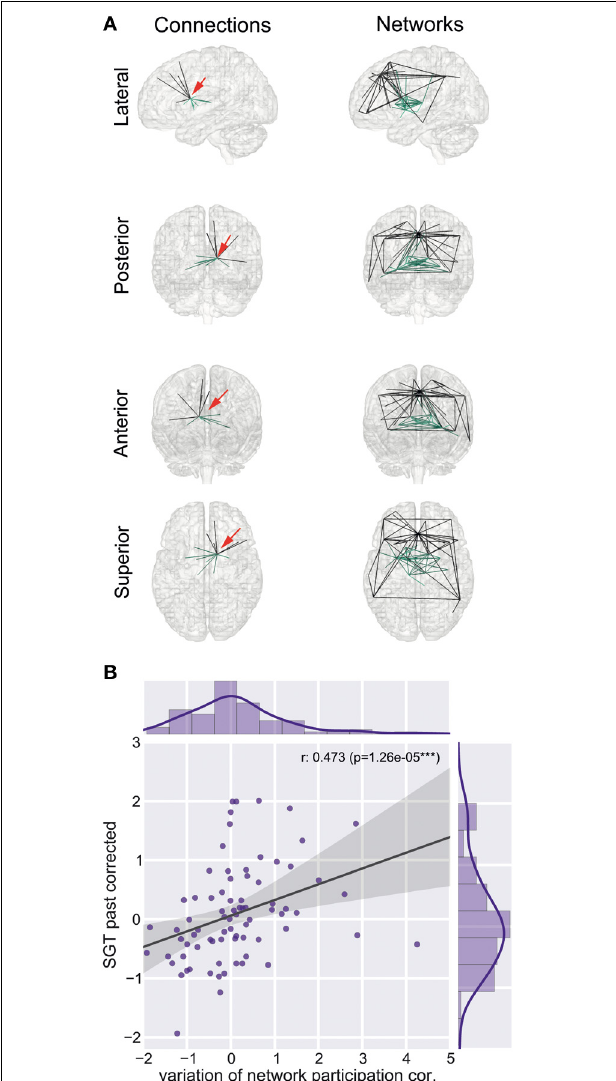
FIGURE 7 | Left caudate region and self-generated thoughts about past events. (A) Left caudate region is part of two connectivity networks, a sub cortical network (network 10) and a subnetwork of the default mode network (network 31). Red arrow indicates the position of the left caudate region. (B) Increased correlation between variation of network participation of the left caudate region and self-generated thoughts about past events.